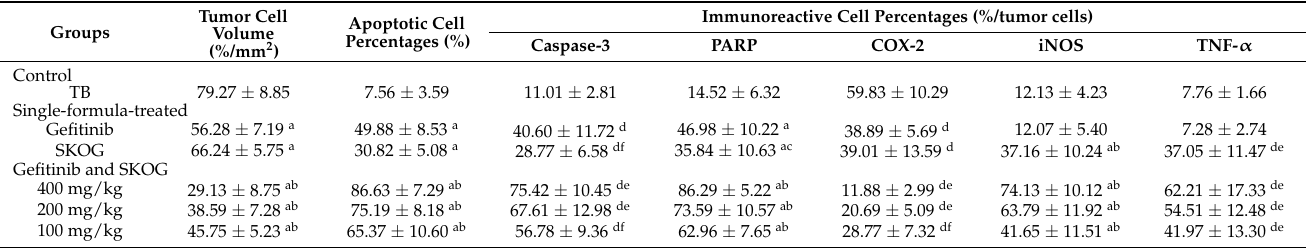
Table 6. Changes in the tumor mass histomorphometry of NCI-H520 tumor cell xenograft